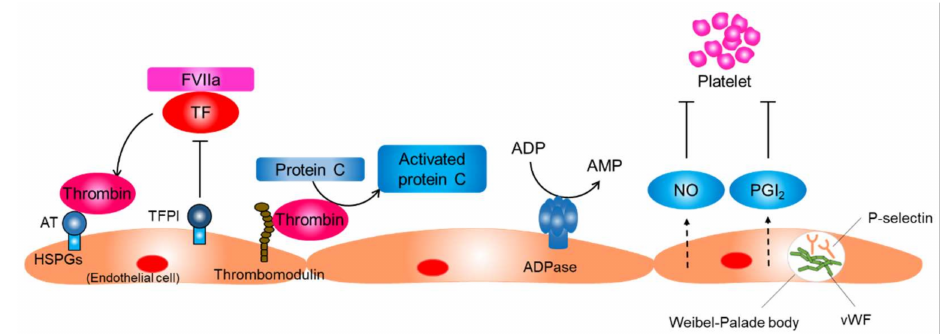
Figure 2. Function of the resting endothelium. The normal resting endothelium plays an important role in maintaining vascular homeostasis by producing several anti-inflammatory and antithrom- botic factors. AT, antithrombin; HSPG, heparin sulfate proteoglycans; TF, tissue factor; TFPI, tis- sue factor pathway inhibitor; FVIIa, factor VIIa; NO, nitric oxide; PGI 2 , prostaglandin I 2 ; vWF, von Willebrand